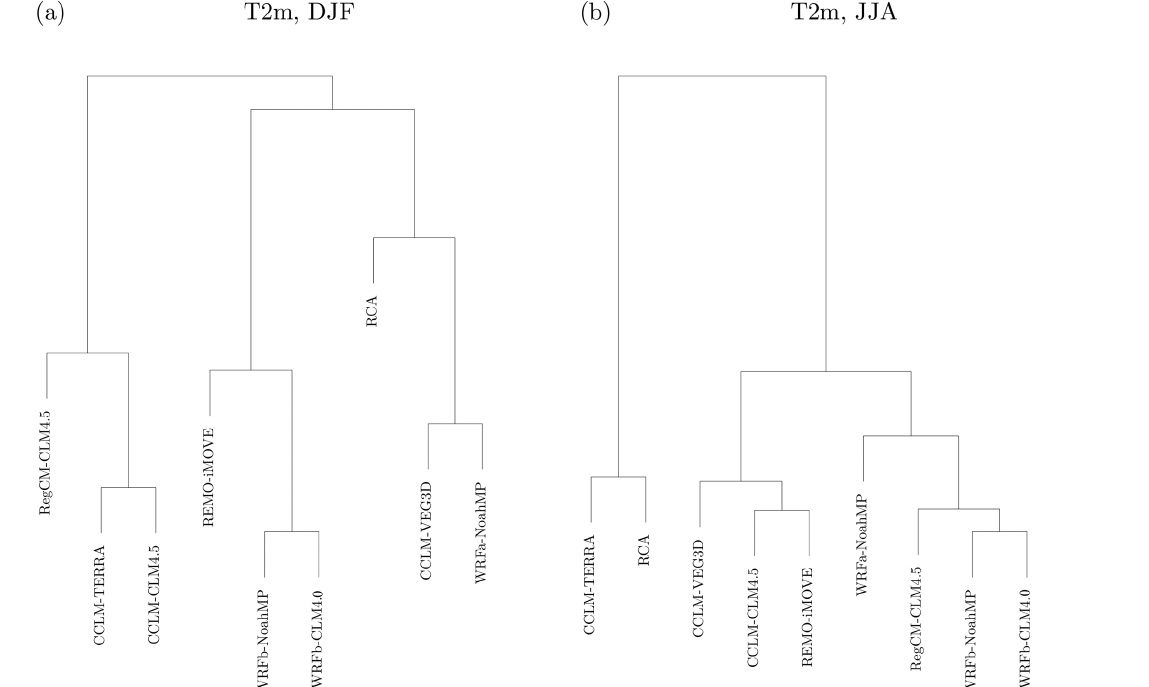
Figure 13. Dendrogram of the clustering analysis based on the 2m temperature response (FOREST minus GRASS) for DJF and JJA. The underlying distance matrix between RCM pairs is based on the Euclidean distance across latitude and longitude for the given